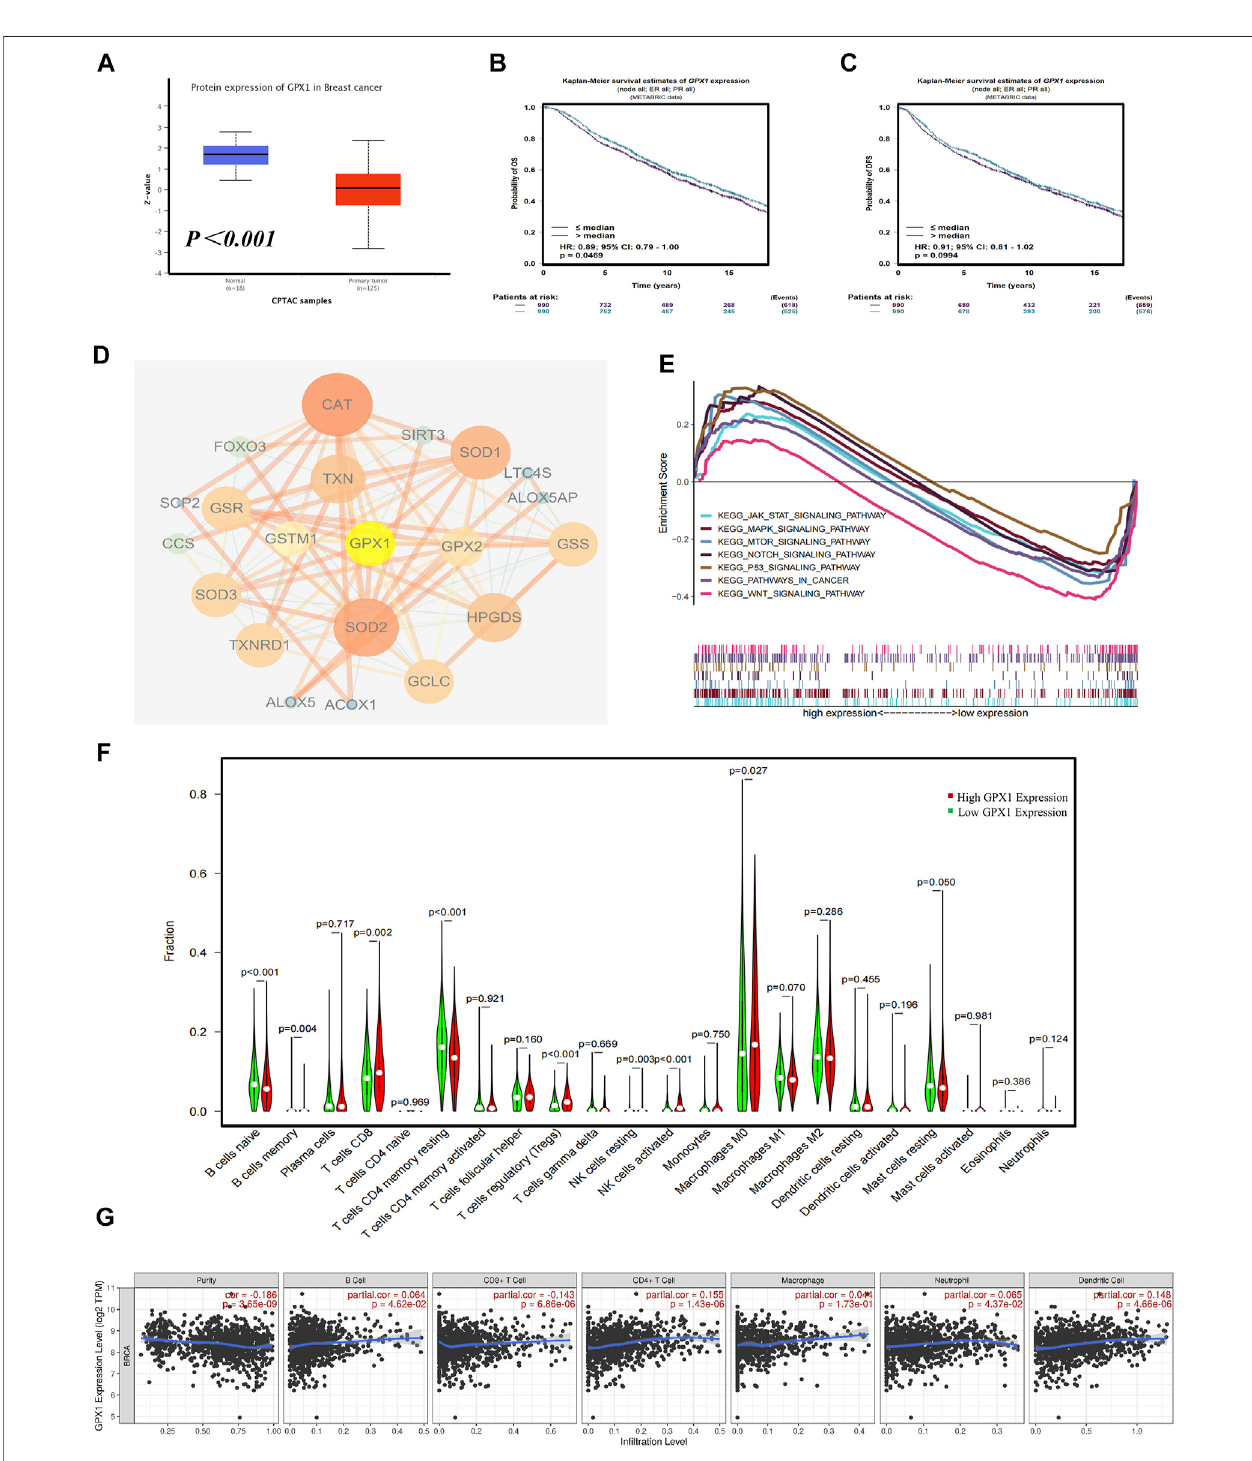
FIGURE 4 | Comprehensive bioinformatics analysis of GPX1. (A) Analysis of the protein expression of GPX1 between normal breast tissue and BC tissue. (B) The OSand (C) DFSofpatientsinthehighandlowGPX1expressiongroups. (D) ThereciprocalproteinsofGPX1. (E) RelatedpathwaysofGPX1byGSEA. (F) Thein fi ltration levels of immune cells in the high and low GPX1 expression groups in patients with BC. (G) Correlation between GPX1 and the abundance of immune in fi ltration.